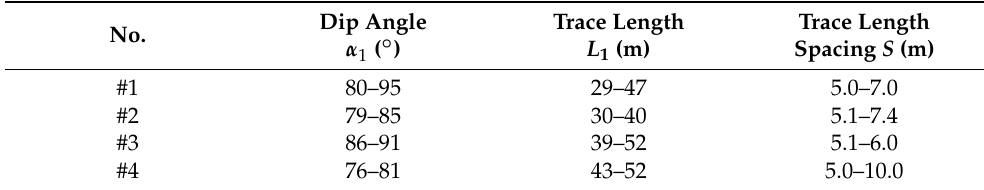
Table 6. Rock fracture parameters of the engineering